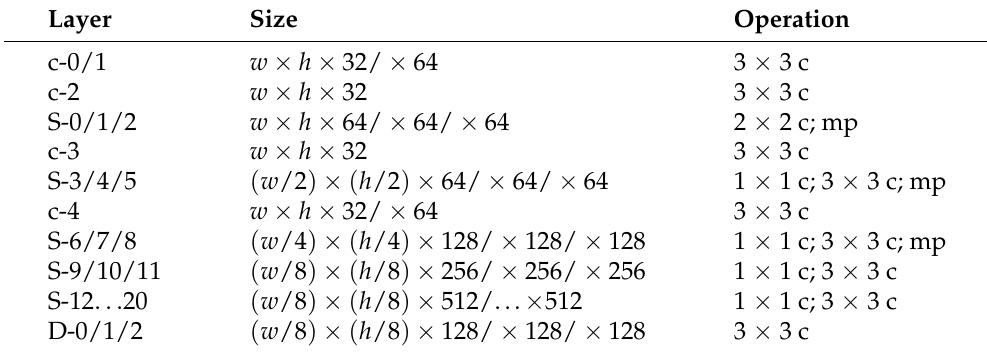
Table 1. Detection network structure parameters. The abbreviations are as follows: C: CNN layer; S: DSC layer; D: DCN layer; mp: maximum pooling